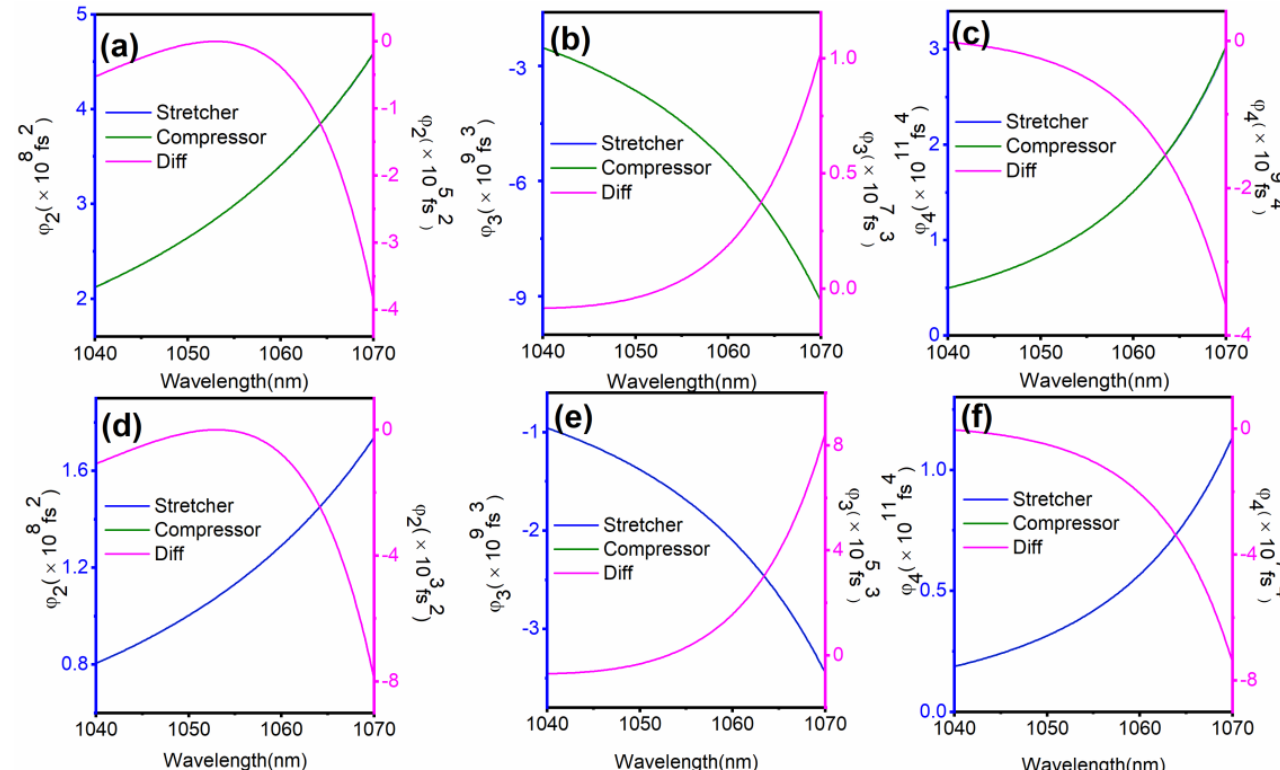
Figure 3. Absolute value of the GVD, TOD, and FOD for pulse durations of 180 fs and 80 fs, which are stretched to 3.3 ns and compressed to FTL, together with the differences of dispersion between stretcher and compressor. ( a ) The GVD and difference for the pulse duration of 180 fs; ( b ) the TOD and difference for the pulse duration of 180 fs; ( c ) the FOD and difference for the pulse duration of 180 fs; ( d – f ) are similar as above for the pulse duration of 80 fs. Compared with the pulse duration of 180 fs, the residual TOD and FOD are small in the multi-PW design with a seed pulse duration of 80 fs. However, to compensate for the dispersion caused by the transmission materials and amplifier mediums [6], in which the GVD, TOD, and FOD are approximately 8.8 × 10 4 fs 2 , 1.54 × 10 5 fs 3 , and − 1.69 × 10 5 fs 4 . An adjustment compressor is used to compensate for the above GVD; however, this process can introduce extra TOD and FOD simultaneously. The change in the distance for adjusting the compressor gratings, GVD, TOD, and FOD for pulse durations of 180 fs (dotted line in blue) and 80 fs (solid in black line) with adjustable pulse durations are shown in Figure 4a–d. To achieve an FTL compressed pulse, the adjusted compressor needs to afford a GVD of − 8.8 × 10 4 fs 2 and introduce an additional but the same TOD of 1.3 × 10 6 fs 3 and FOD of − 3 × 10 7 fs 4 simultaneously. After compensating for the GVD of the transmission materials, the final TOD and FOD for the existing SG PW laser system are 1.3 × 10 6 fs 3 and − 3.9 × 10 8 fs 4 for a pulse duration of 180 fs and 1.3 × 10 6 fs 3 and − 3.8 × 10 7 fs 4 for a pulse duration of 80 fs. The values agree with the implementation of pulse duration controlled by the adjustment compressor in the SG PW laser and can provide a basis for the multi-PW